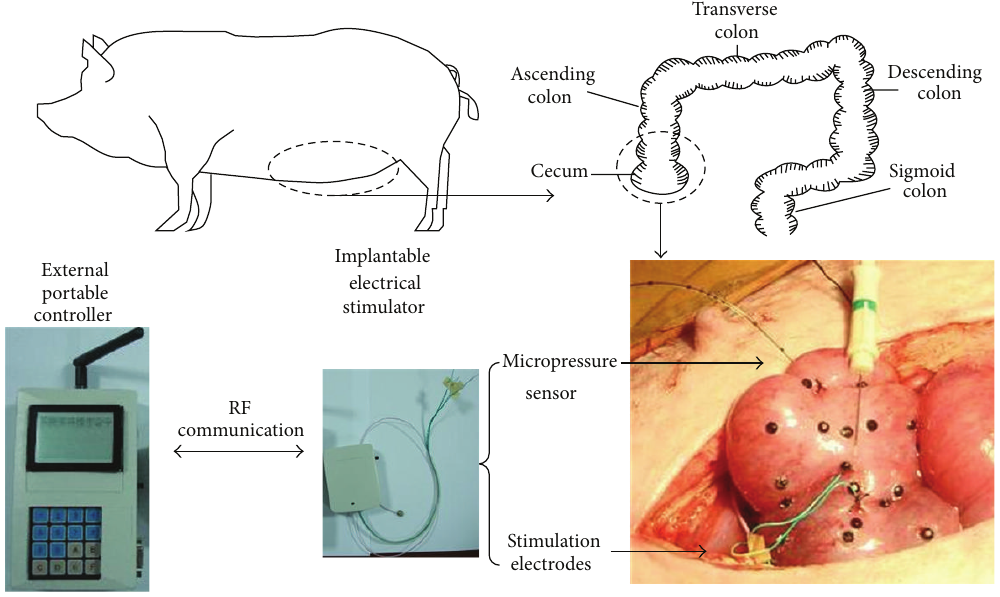
Figure 6: Animal experiment. Table 3: Reactions of the cecum to different stimulation